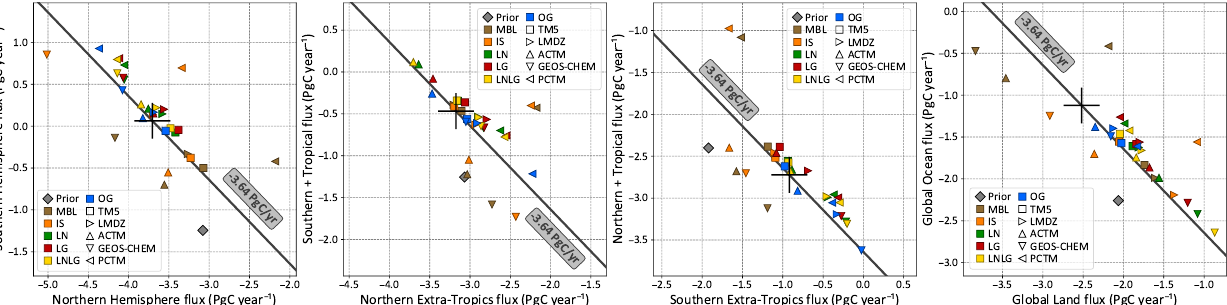
Figure 7. The partitioning of the 2015 global CO 2 sink into two geographical domains, with the tropics being defined as 23.5 ◦ N and S latitudes. Each color represents one type of synthetic data assimilated, while each symbol shape represents one model used to generate the synthetic data. The diagonal gray line represents the 2015 global sink of 3.64PgCyr − 1 in the true fluxes used to generate the synthetic data, while the large plus sign denotes their partitioning. The scales are identical across all four panels, but not the